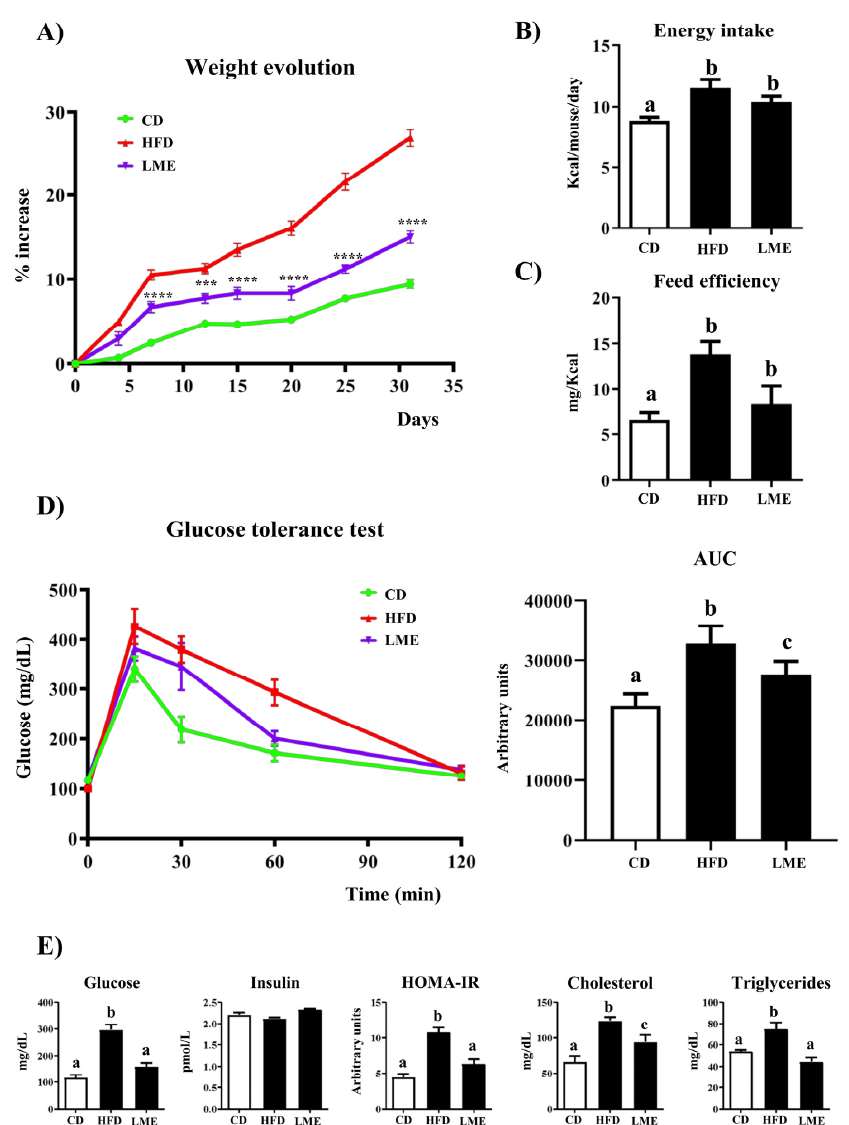
Figure 5. Effects of LME supplementation on ( A ) body weight evolution; ( B ) energy efficiency and ( C ) energy intake; ( D ) glucose tolerance test and area under the curve (AUC); and ( E ) glucose, insulin levels, and HOMA-IR index; total cholesterol plasma levels and triglycerides in control (CD) and high-fat diet (HFD)-fed mice. Data are expressed as means ± SEM ( n = 8). Groups with different letters statistically differ ( p < 0.05); *** p < 0.001 and **** p < 0.0001 vs. HFD-fed